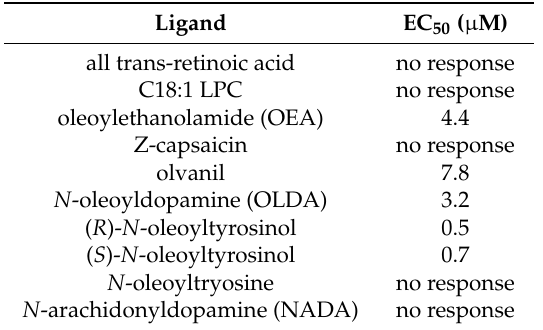
Table 2. Affinity of representative compounds including fatty acids for GPR119 [74].